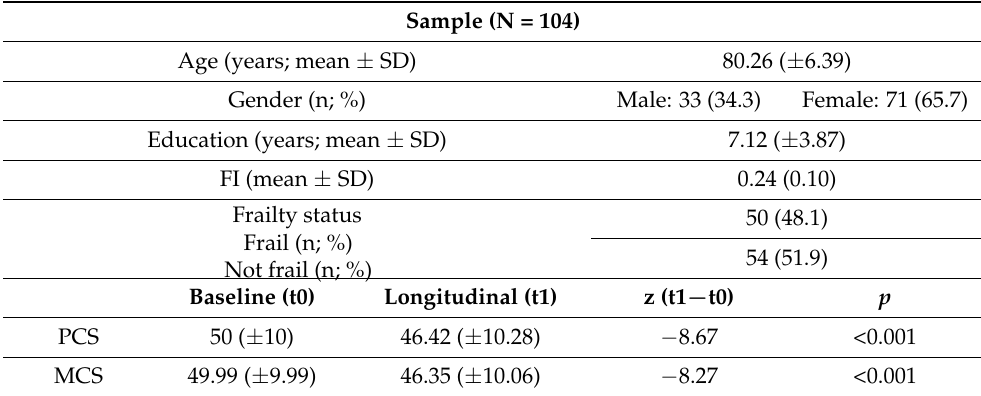
Table 3. Principal sociodemographic and clinical characteristics of the sample evaluated during the COVID-19 outbreak in